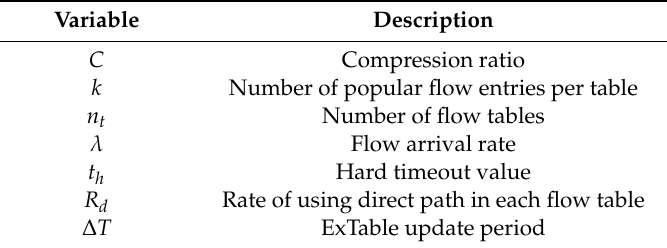
Table 9. The factors in the simulation.